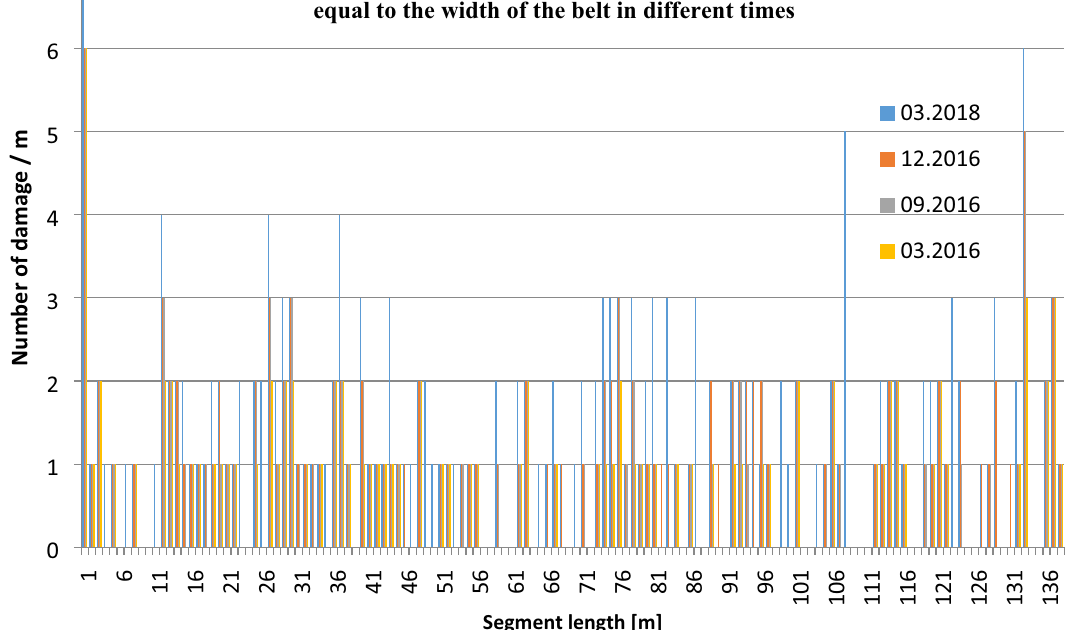
Figure 7. Number of defects in 1-m segments of the belt section along its axis (X direction) in consecutive scans from March, September and December 2016, as well as from March 2018 5,42 (Microsoft Excel, version 2010, own